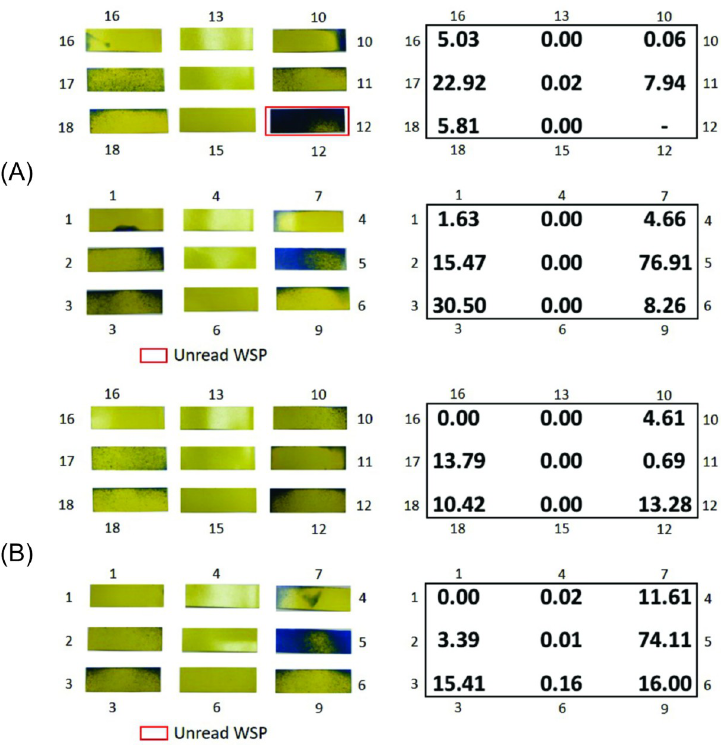
Fig 9. WSPs exposed to the biocidal agent for 10 s and their percentage wet area values. (A) Sample 1; (B) Sample 2.